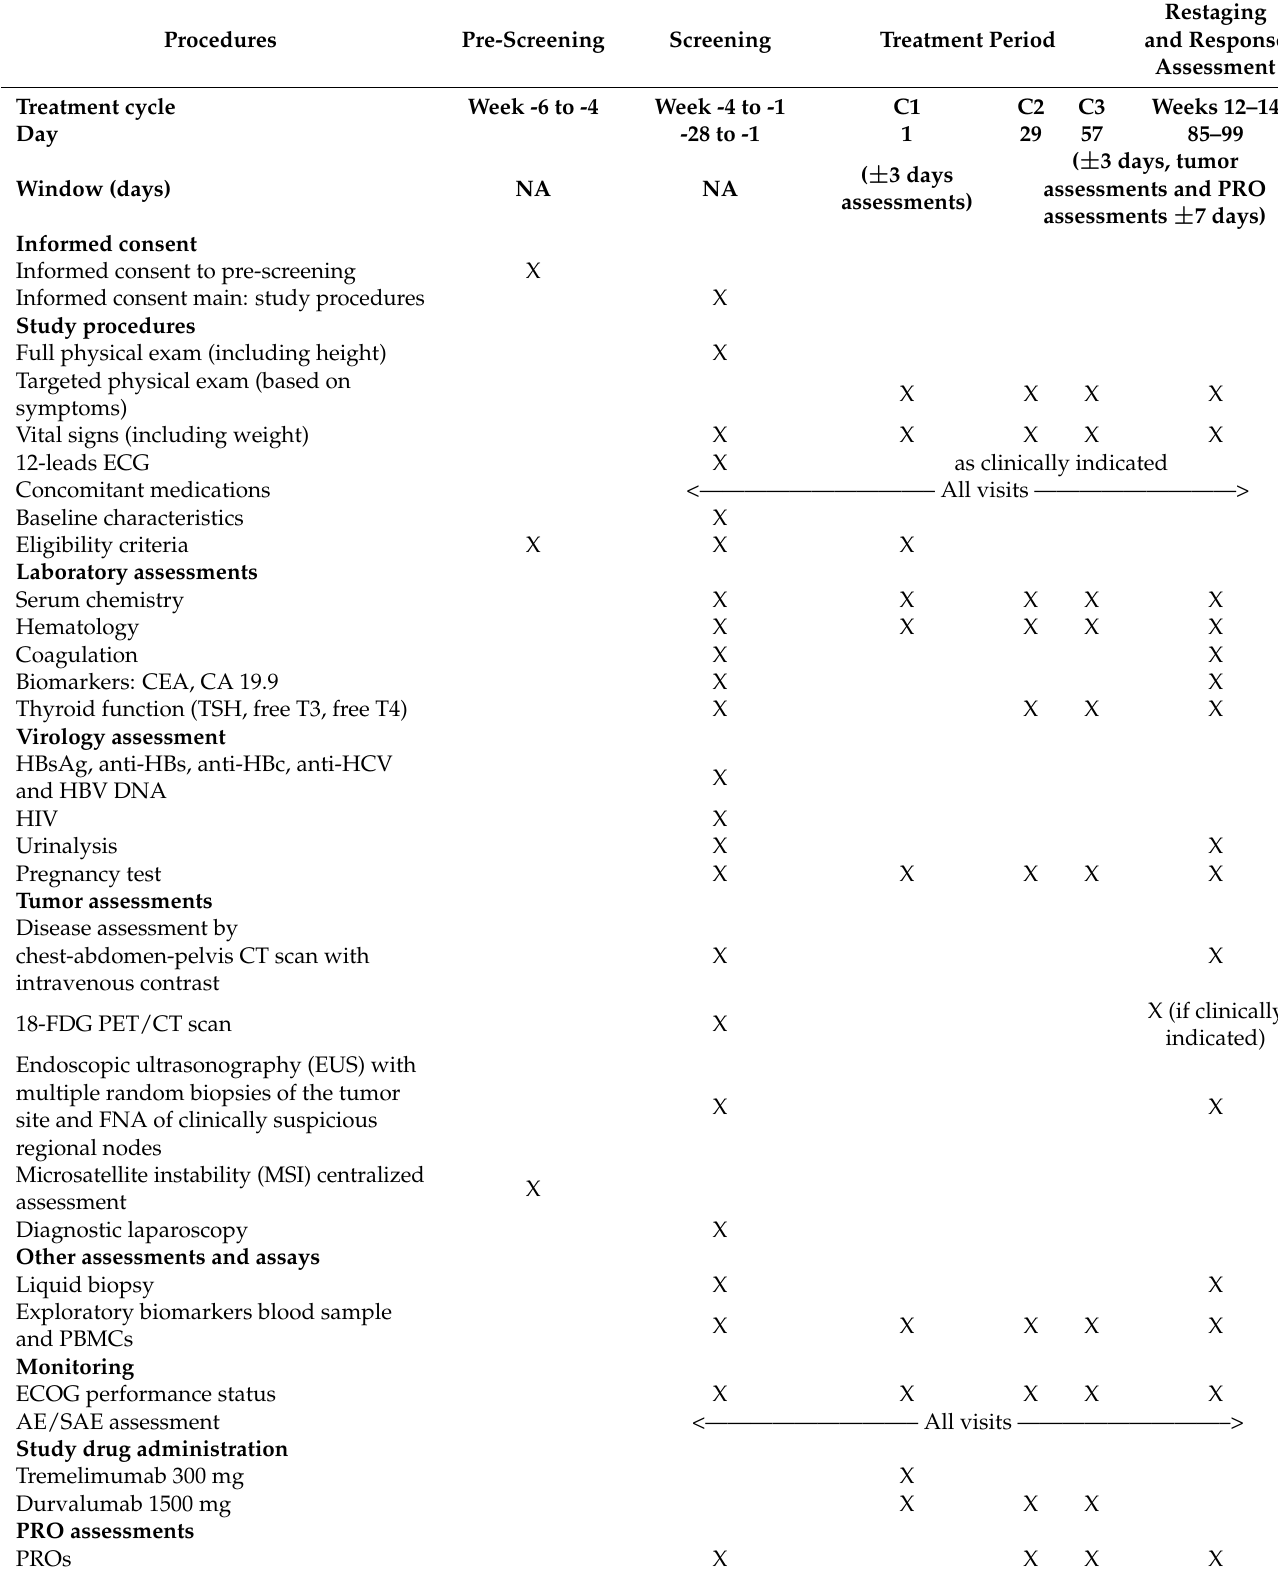
Table 1. Schedule of assessments for all pre-operative immunotherapy arms (Cohort 1 and